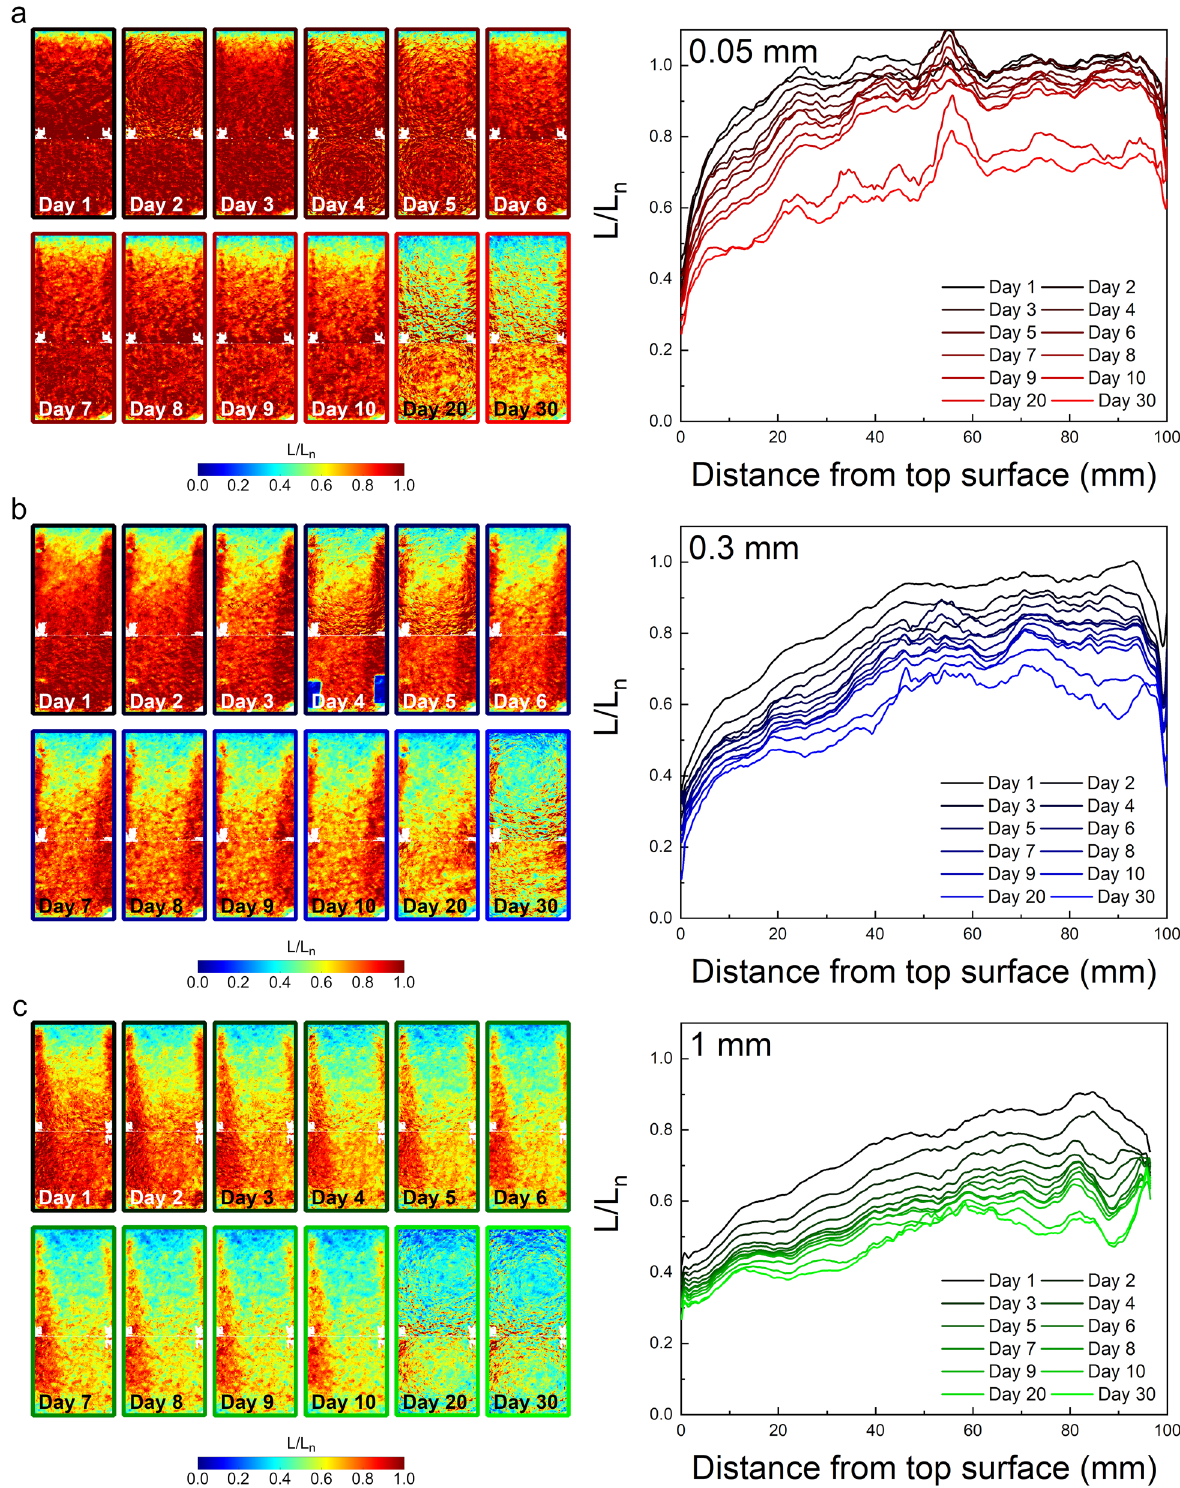
Figure 3. (Left column) Normalized IRPL 955 maps along the crack surface and the corresponding luminescence profiles as a function of distance down the crack. The data are shown for the three different crack widths ( a red) 0.05, ( b blue) 0.3 and ( c green) 1 mm. (Right column) The right side of each figure shows the normalized IRPL 955 signal as a function of the distance from the top